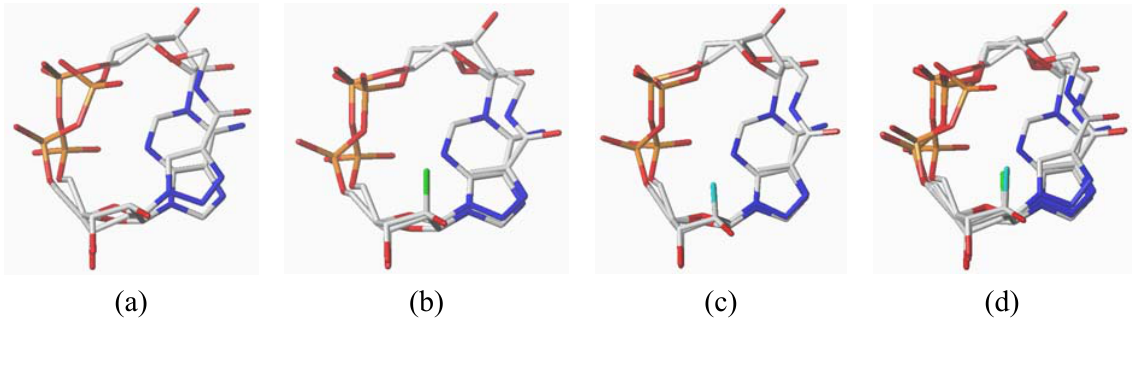
Figure 3. Superimposition of minimized conformations of cADPR and compounds 5a (a), 5b (b), 5c (c) and 5a – c